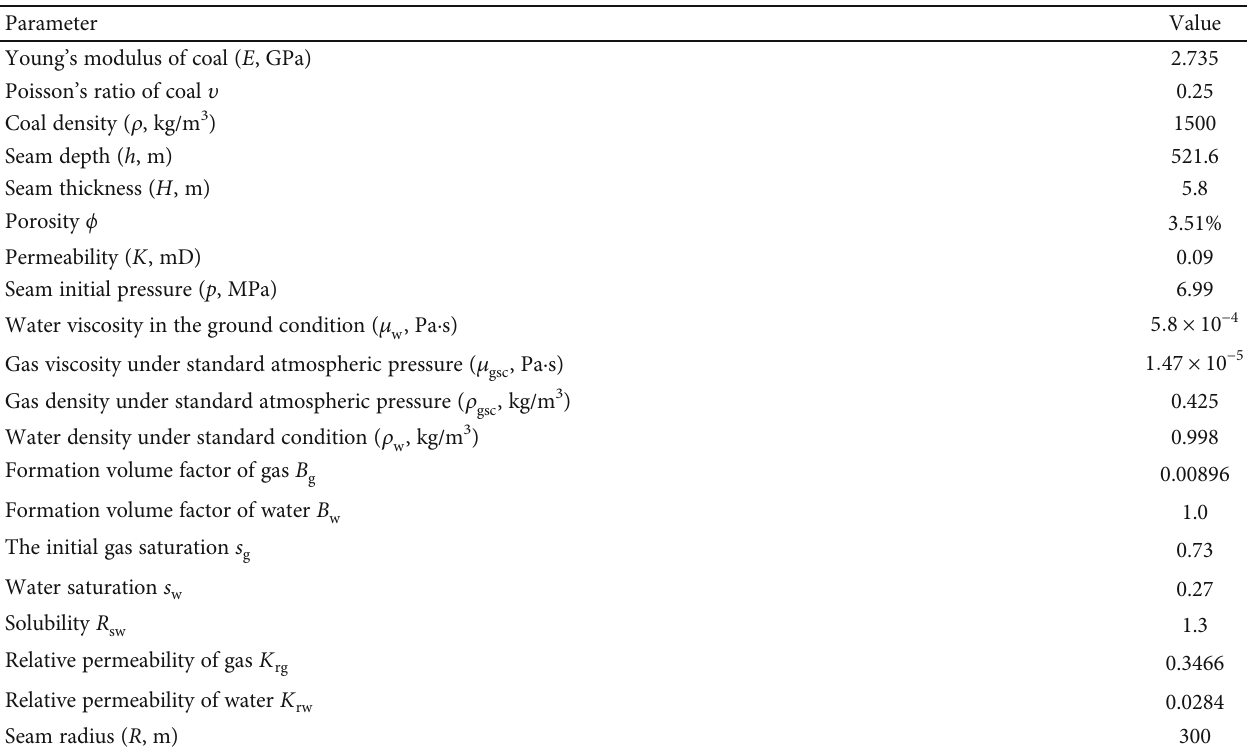
Table 4: Physical parameters of coal